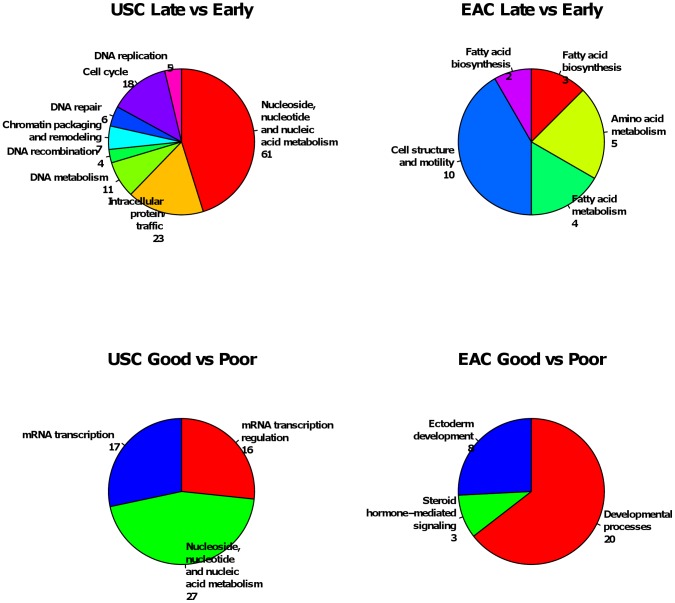
Enriched function annotation of differentially expressed genes
(P<0.01) identified by microarray.Enriched functional annotations are reported by NCBI DAVID API server
with default setting. The number following each enriched functional term
is the number of annotated DEGs. A) Enriched functional
annotation for stage-related DEGs (late versus early) in USC group.
B) Enriched functional annotation for stage-related
DEGs in EAC group. C) Enriched functional annotation
for outcome-related DEGs (good versus poor) in USC group.
D) Enriched functional annotation for
outcome-related DEGs in EAC group.